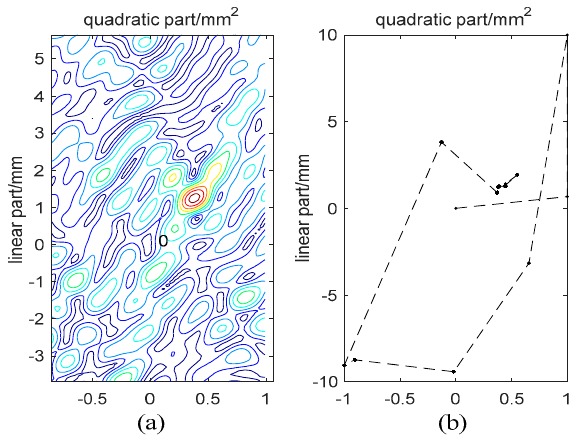
Figure 2. Sensors 2019 , 19 , 115